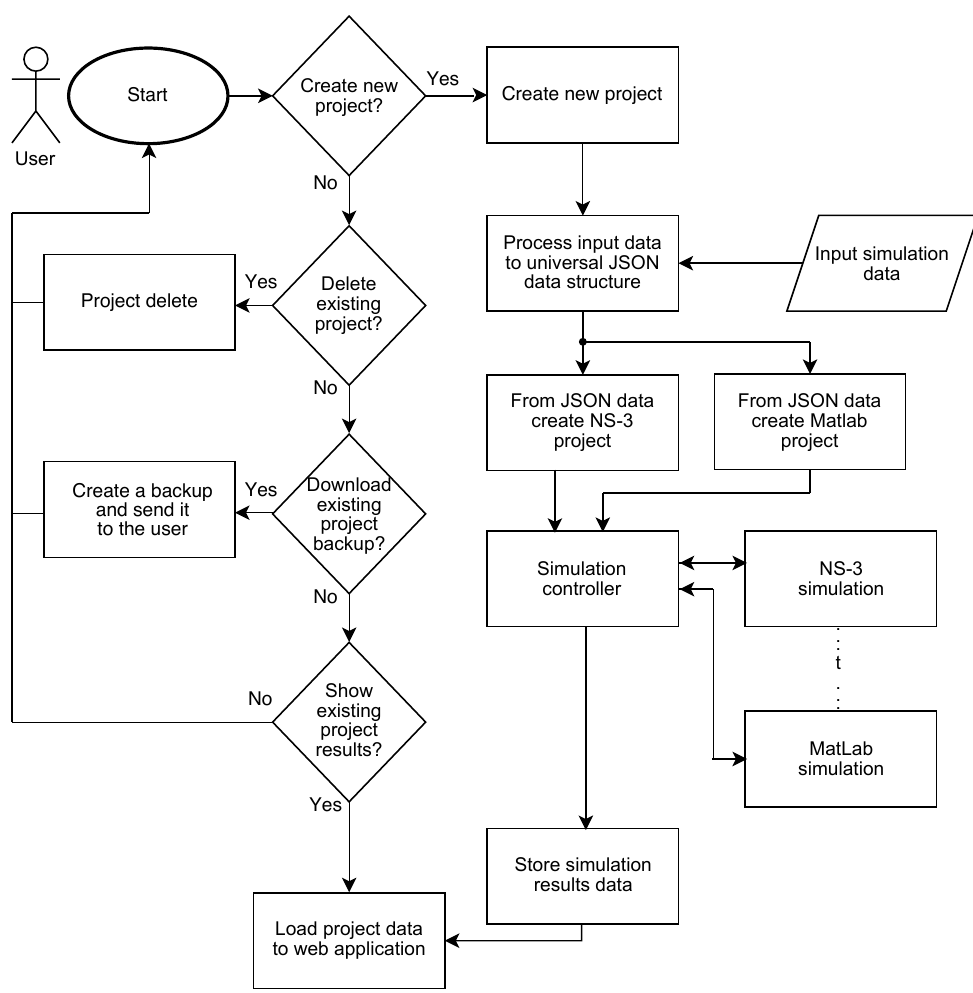
Figure 5. Program architecture diagram with terminal